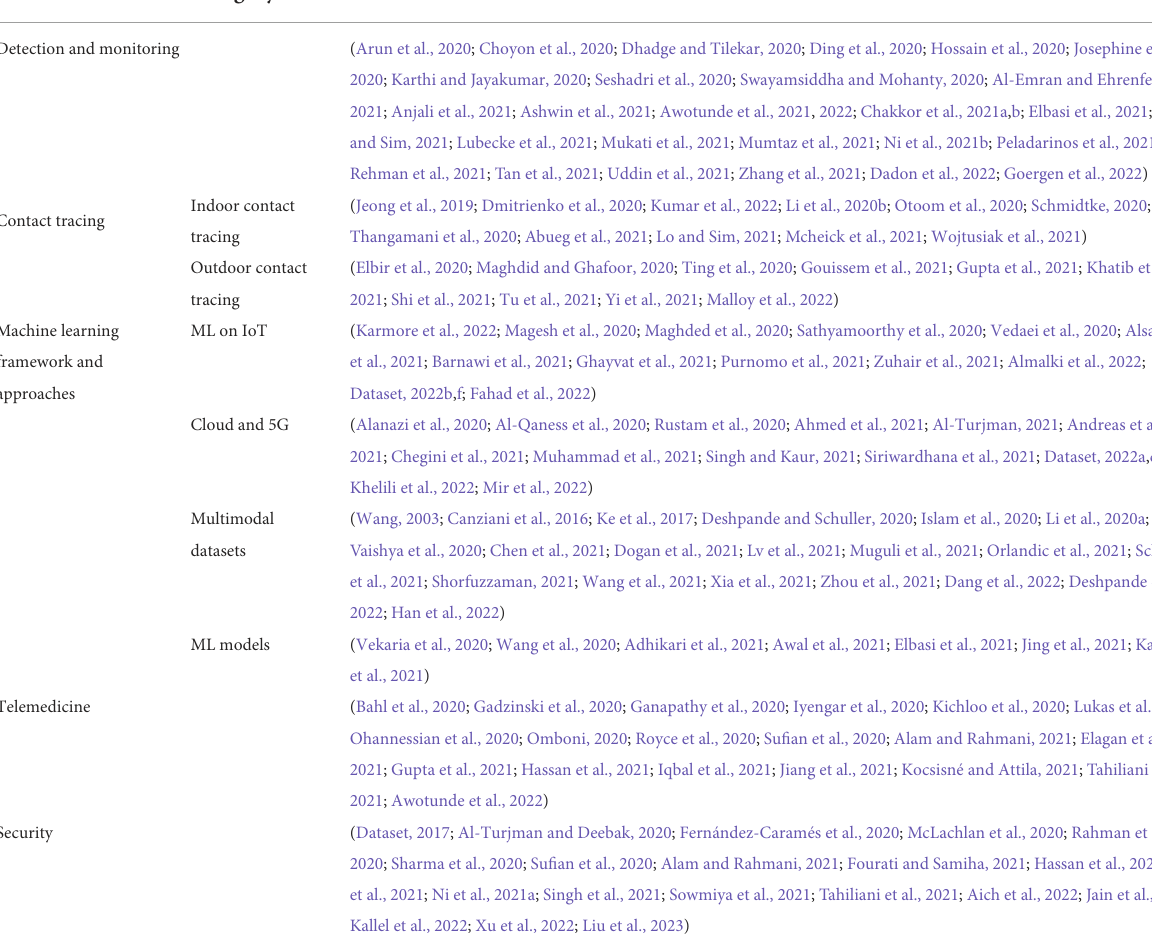
TABLE 2 An overview of all methods and papers reviewed in this